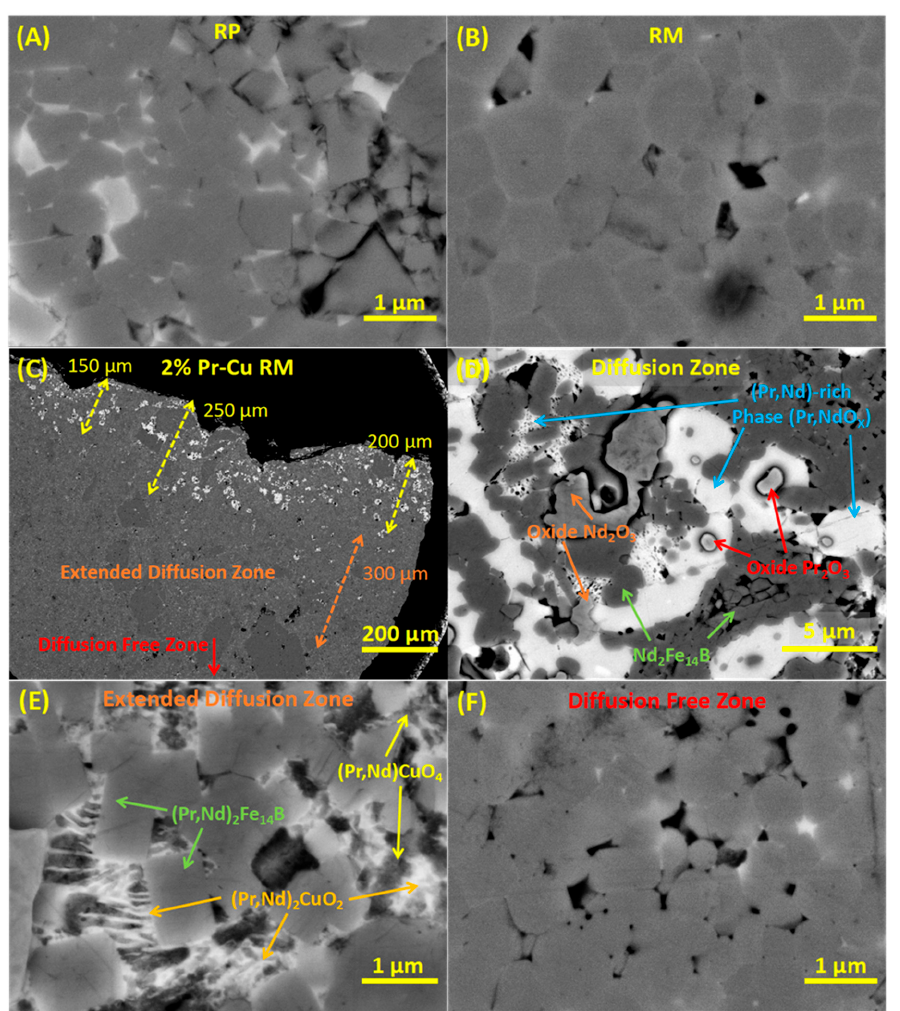
Figure 3. BSE-SEM analysis, high magnification image of: ( A ) bonded recycled HDDR Nd-Fe-B powder (RP); ( B ) optimally SPS-ed HDDR Nd-Fe-B bulk magnet (RM) prior to GBDP; ( C ) micrograph of 2 wt. % Pr-Cu GBDP specimen indicating diffusion zones after secondary annealing; ( D ) close-up image of diffusion zone with different phases quantified in Table 2; ( E ) the diffusion zone extension due to secondary annealing showing the distribution of Pr-Cu-rich phase at the intergranular regions; and ( F ) di ff usion free zone which mimics the microstructure of original RM due to limited di ff usion depth of Pr-Cu alloys in HDDR Nd-Fe-B